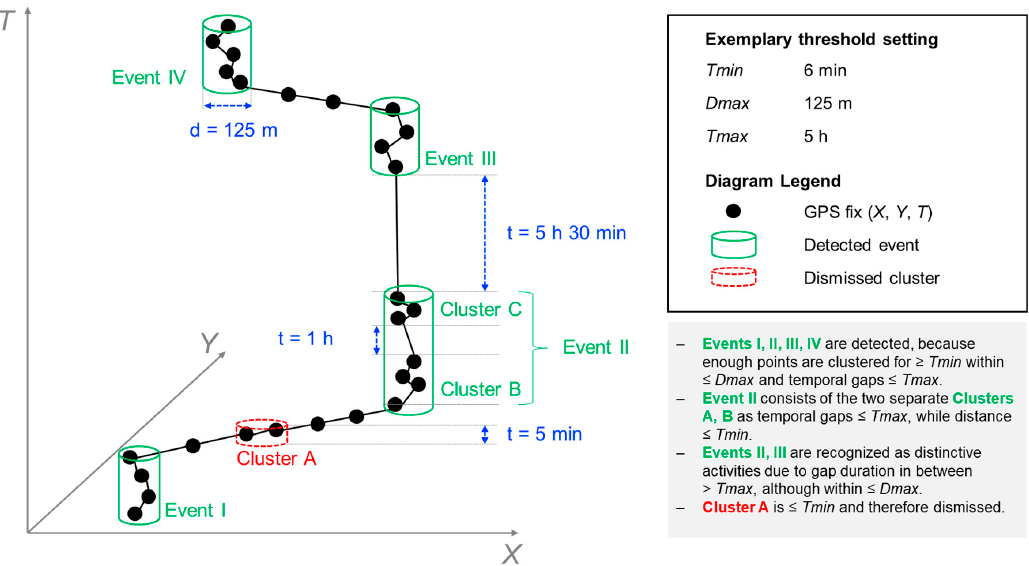
Figure 1. Schematic representation of automatic activity location detection based on spatial ( Dmax ) and temporal parameters ( Tmin , Tmax ), depicted in a space–time cube. The example thresholds used in this illustration ( Tmin = 6 min, Dmax = 125 m, Tmax = 5 h) are the ones that were derived from the sensitivity analysis (see Section 4.2).